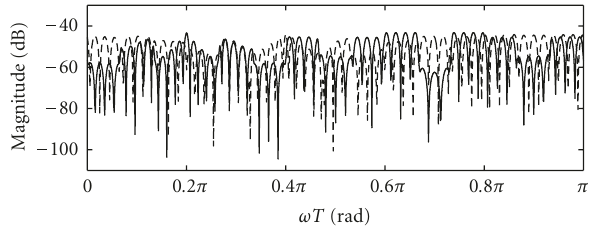
Figure 9: Magnitude responses of the aliasing functions without the nonlinear optimization procedure with N G = 47 and N F = 102, Example 1.